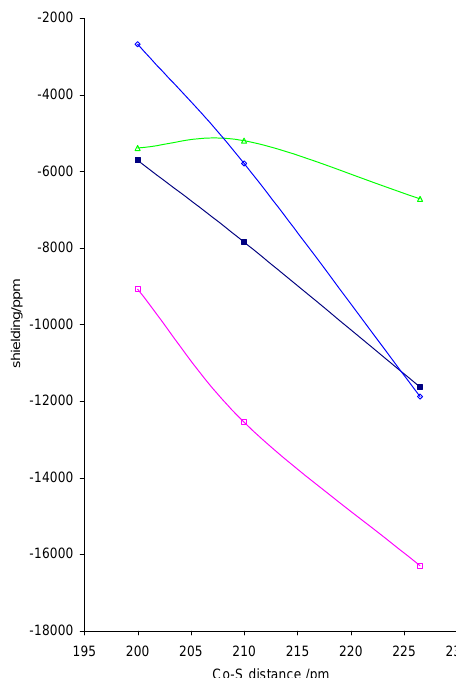
Figure 2. Calculated variation of Co shielding with Co-S distance for dithiocarbamato complexes with r(co-N) =1.728Å, r(NO) = 1.10Å and a CoNO angle of 120°. ■ isotropic shielding, □ σ . σ zz